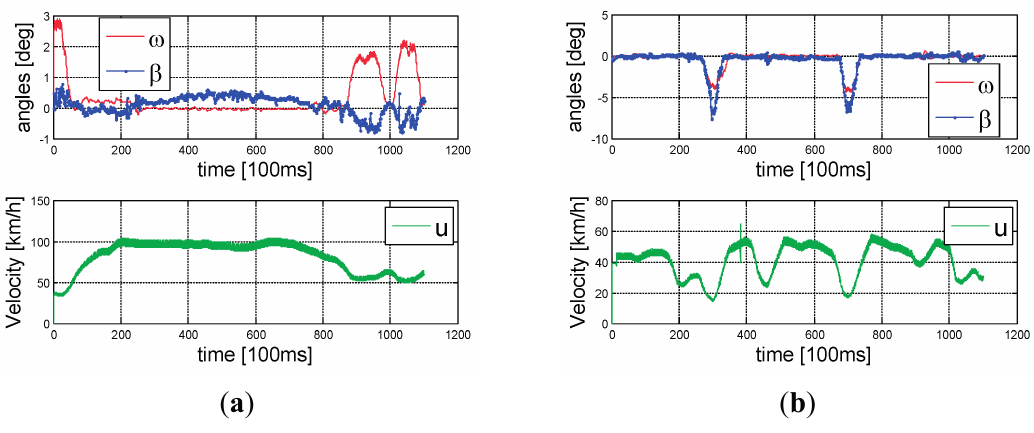
Figure 4. Plots of yaw angle increment ω (at approximately 100 ms interval) and side slip angle β from the KITTI ground truth data at ( a ) high speed and ( b ) low